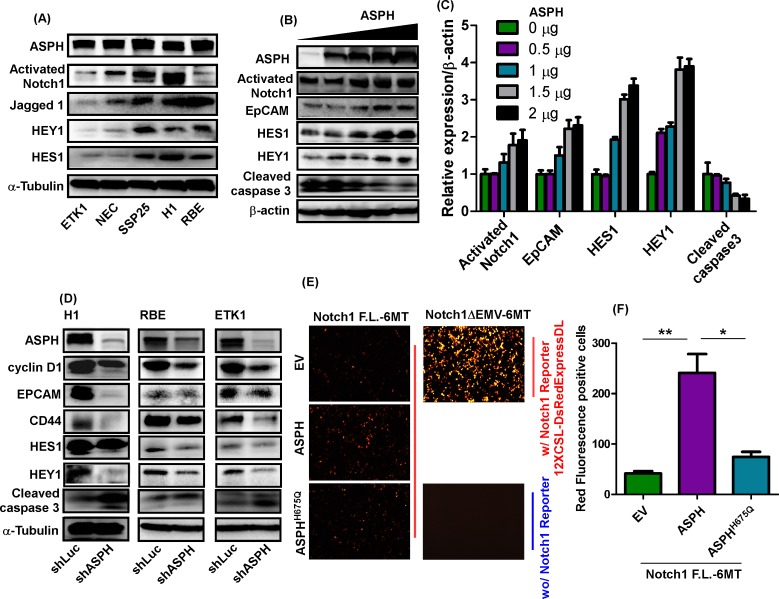
ASPH modulated Notch signaling in CCA cells.(A) Protein expression levels of ASPH, activated Notch1, JAG1, HEY1, and HES1 in 5 CCA cell lines. (B) ASPH, cyclin D1, EpCAM, HES1, HEY1, and cleaved caspase-3 in HEK293 cells transfected with WT-ASPH plasmid at concentrations of 0, 0.5, 1, 1.5, 2, and 2.5 μg. (C) Semi-quantitation of immunoblotting results depicted in (B). (D) Expression levels of ASPH, cyclin D1, EpCAM, CD44, HES1, HEY1, and cleaved caspase-3 in H1, RBE, and ETK1 cells infected with lentivirus containing either shLuc or shASPH. (E) pCS2-Notch1-full-length-6MT (pCS2-Notch1-F.L.-6MT), EV, ASPH, ASPHH675Q, and 12XCSL-DsRedExpressDL (Notch reporter) were co-transfected into HEK293 cells and image of red fluorescence was quantified under a fluorescence microscope. (F) Quantitation of red fluorescence signals are presented. Constitutive active Notch1 (pCS2-Notch1-ΔEMV-6MT) was used as a positive control. Transfection of Notch reporter construct alone was used as a negative control.